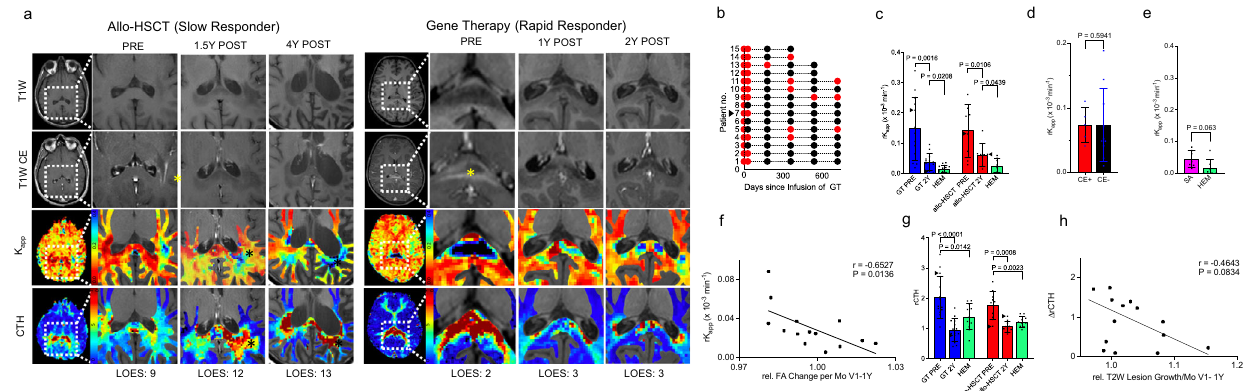
Fig. 2 | Effects of allo-HSCT and gene therapy on in fl ammatory CALD lesions. a RepresentativeT1-weightedimageswithout(T1W)andwithgadoliniumcontrast enhancement (T1W CE), the apparent contrast leakage parameter ( K app ) and capillary fl ow heterogeneity (CTH) maps of two CALD patients before (PRE) and after (POST) treatment with allogenic hematopoietic stem-cell transplantation (allo-HSCT, left) or gene therapy (GT, right). Lesion magni fi cations in PRE show strong CE ring enhancement which resolved POST treatment in both patients, while POST K app - and CTH maps show persisting regionally increased BBB- permeability and microvascular fl ow heterogeneity in the allo-HSCT patient, in contrast to a GT-treated patient with rapid normalization of microvascular per- fusion markers. Data points of these patients are highlighted with pointing tri- angles in the following fi gures. b Longitudinal data on binary contrast reads (yes vs. no pathologic CE) in GT patients ( n =15). c Lesional relative K app PRE and 2Y post GT ( n =13) and allo-HSCT ( n =8) and relative K app in corresponding white matter in age-matched hemizygotes without CALD (HEM, n =11 – 8). Error bars